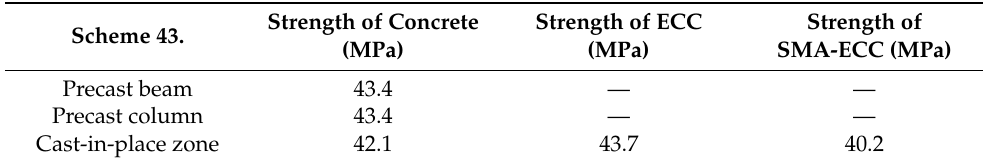
Table 5. Compressive strength of concrete, ECC, and SMA-ECC.